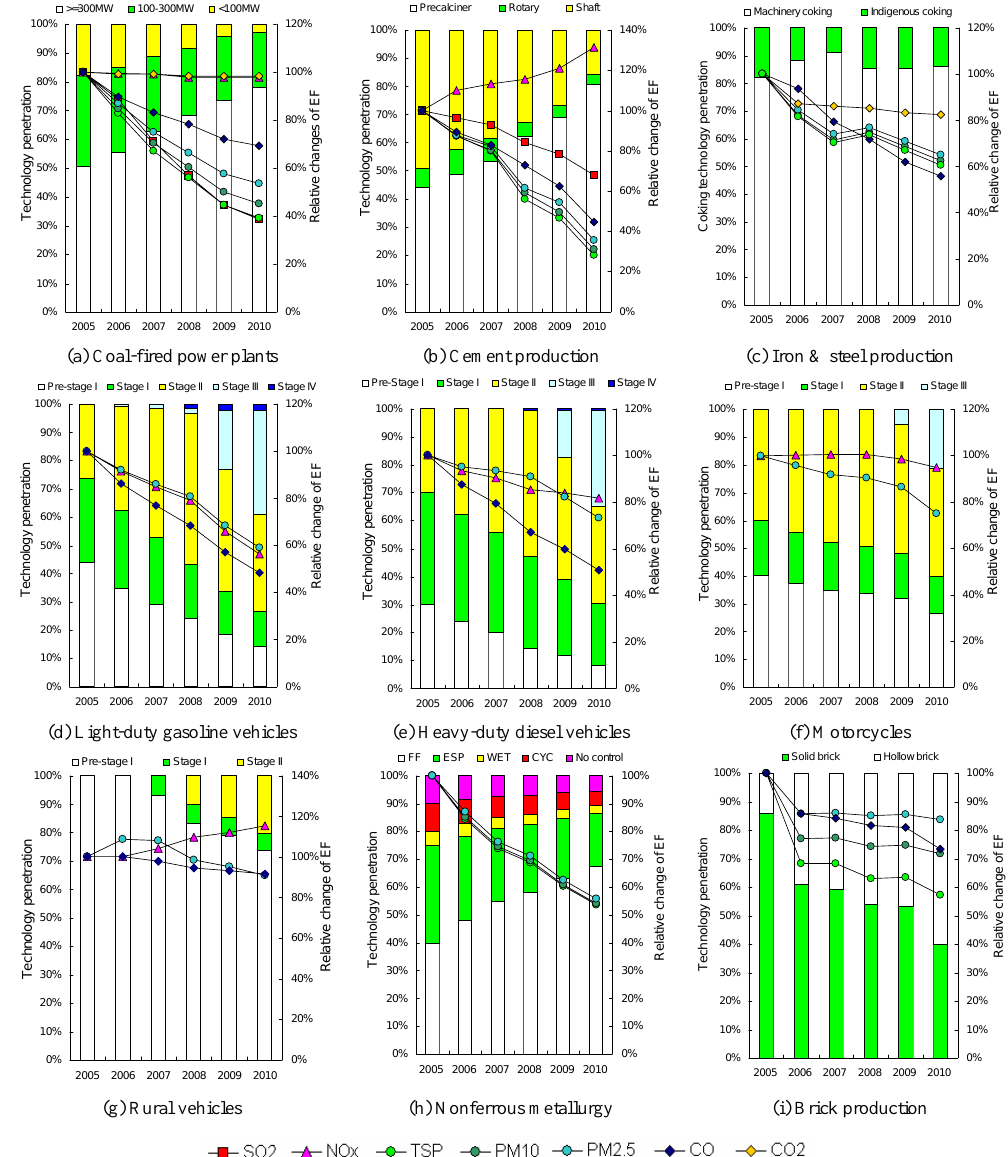
Fig. 2. The penetrations of technologies and inter-annual trends of emission factors for typical sources in China from 2005 to 2010. In each panel, left-hand vertical axis indicates the percentages of various technologies and right-hand vertical axis indicates the relative changes of emission factors for various